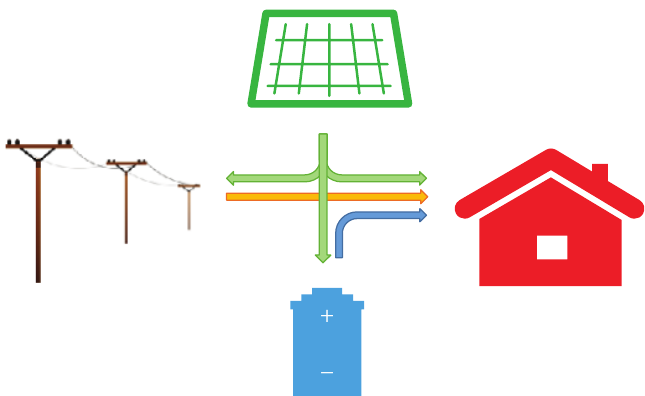
Figure 3: An integrated photovoltaic battery energy storage system (PV-BES).